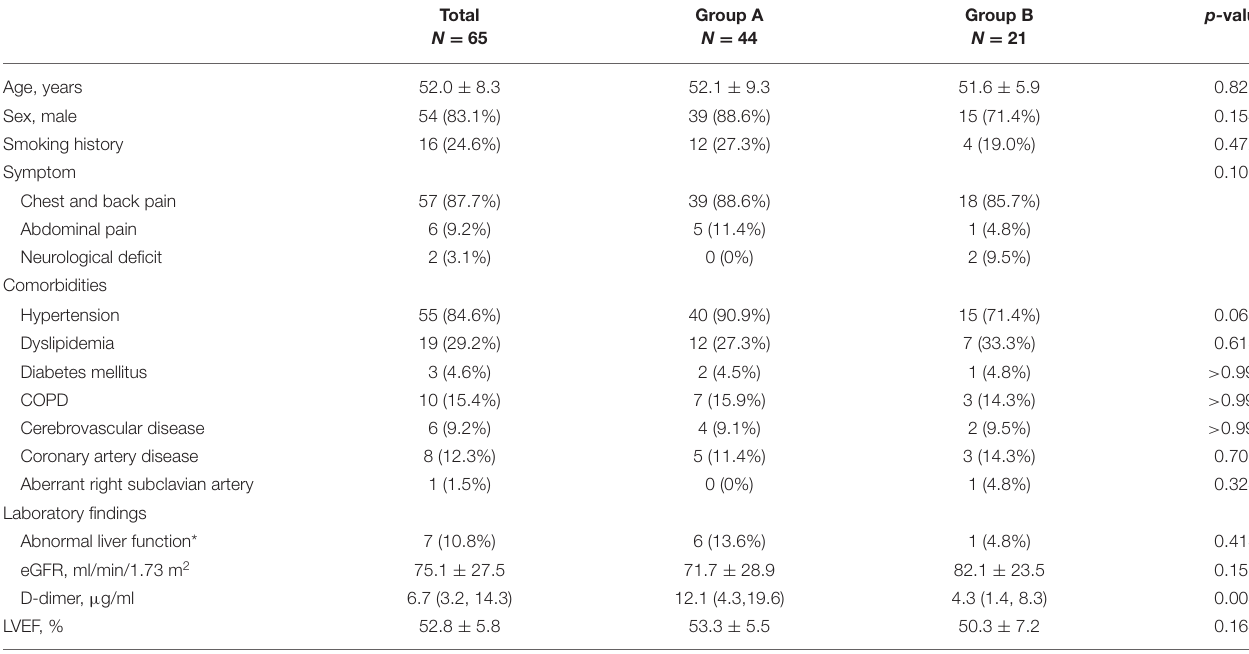
TABLE 1 | Clinical characteristics in patients with entry tear (Group A) and penetrating atherosclerotic ulcer (Group B) on